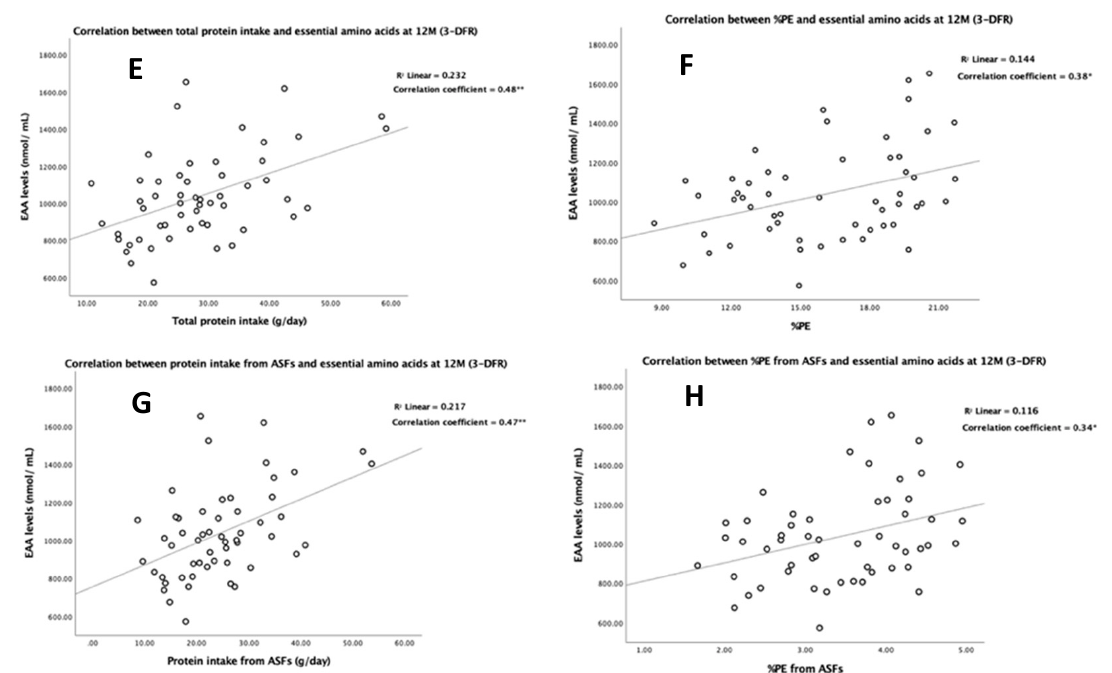
Figure 2. Correlations between protein intake from 3-day food records (3-DFR) and plasma amino acids at 12 M. The triangles ( ∆ ) and circles (O) represent the associations between protein intakes and plasma levels of branched-chain amino acids (BCAA) and essential amino acids (EAA), respectively. The coefficient of determination (R 2 ) and correlation coefficients (r) are shown in the right upper corner of all scatter plots. Significant p -values are shown as * ( p < 0.05) and ** ( p < 0.001). Correlations between plasma levels of BCAA and total protein intake, protein–energy percentage (%PE), protein intake from animal source foods (ASFs) and %PE from ASFs are shown in graphs A, B, C and D, respectively. Correlations between plasma levels of EAA and total protein intake, %PE, protein intake ASFs and %PE from ASFs are shown in graphs E, F, G and H, respectively. Table 6. Multivariate regression analysis predicting plasma amino acids by protein intake at 12 M. BCAA Levels EAA Levels NEAA Levels Total AA Levels Protein Intake Crude Adjusted 1 Crude Adjusted 1 (g/day) β β β β β